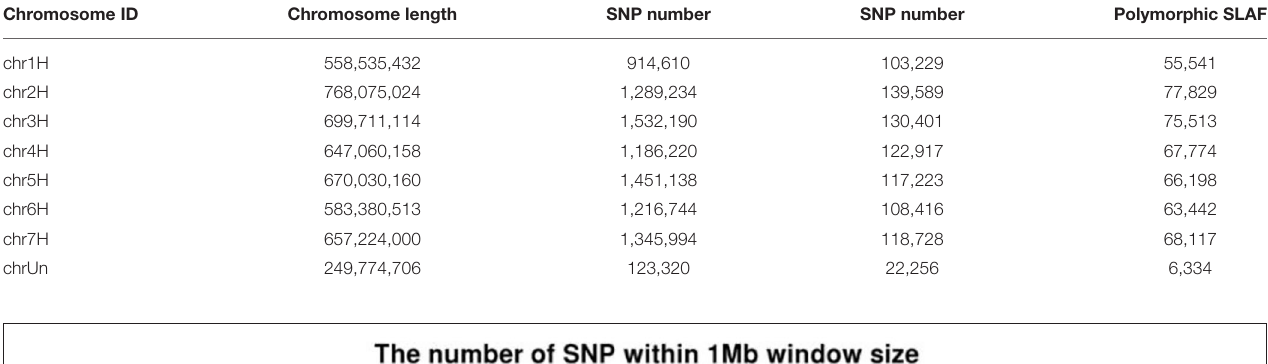
TABLE 1 | Distribution of SLAF markers on chromosomes.